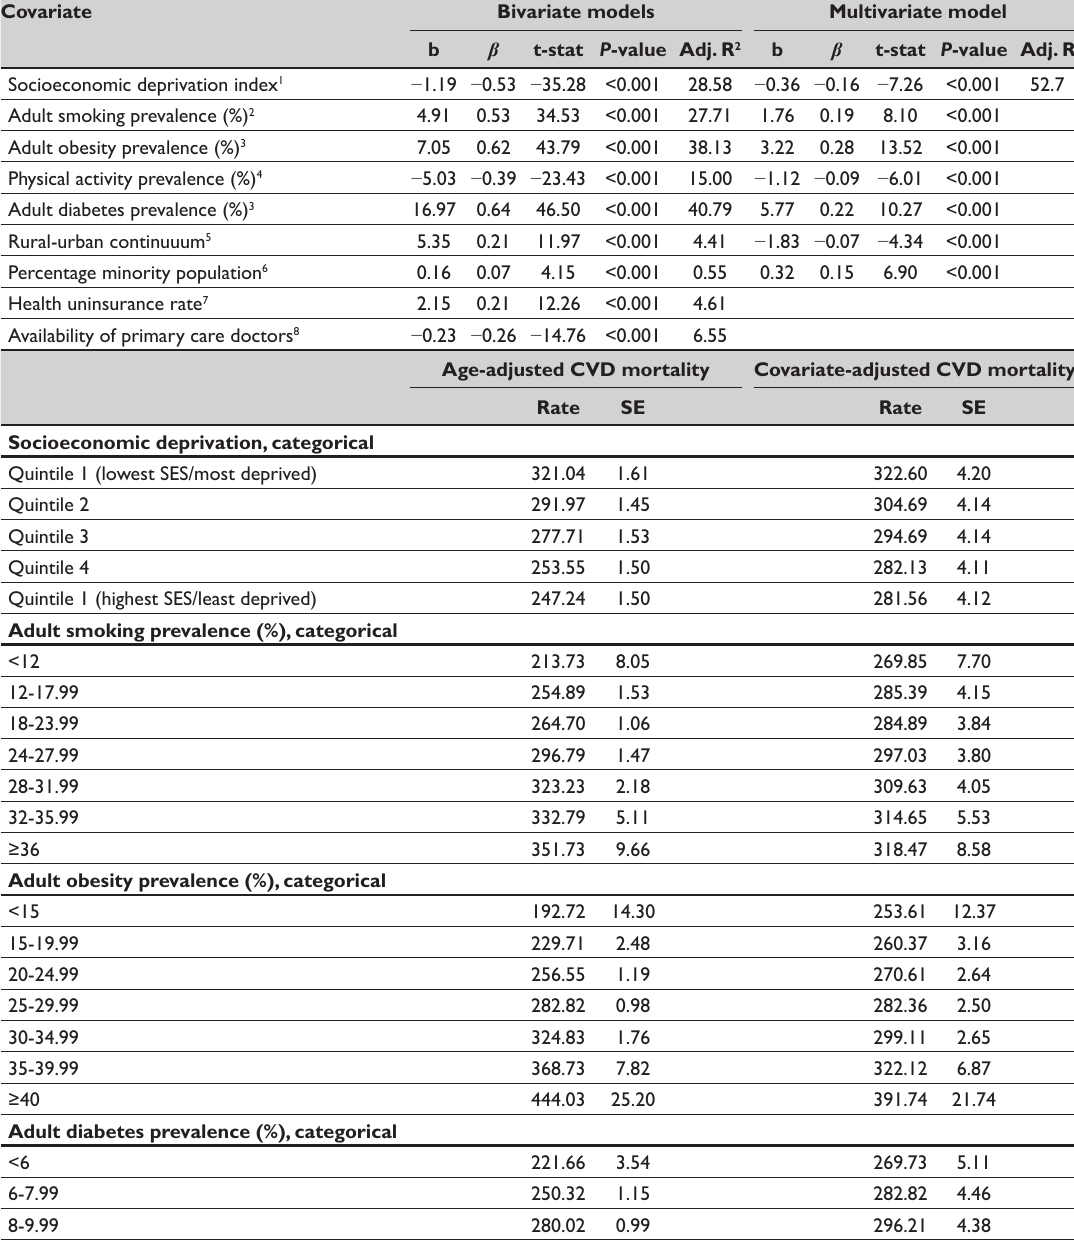
Table 5. Weighted Least Squares Regression Models Showing the Impacts of the Continuous and Categorical Socioeconomic Deprivation Index, Smoking, Obesity, Physical Activity, Diabetes Prevalence, Rural-Urban Continuum, and Racial/Ethnic Composition on County-Level Age-Adjusted Cardiovascular Disease (CVD) Mortality Rates: United States, 2003-2007